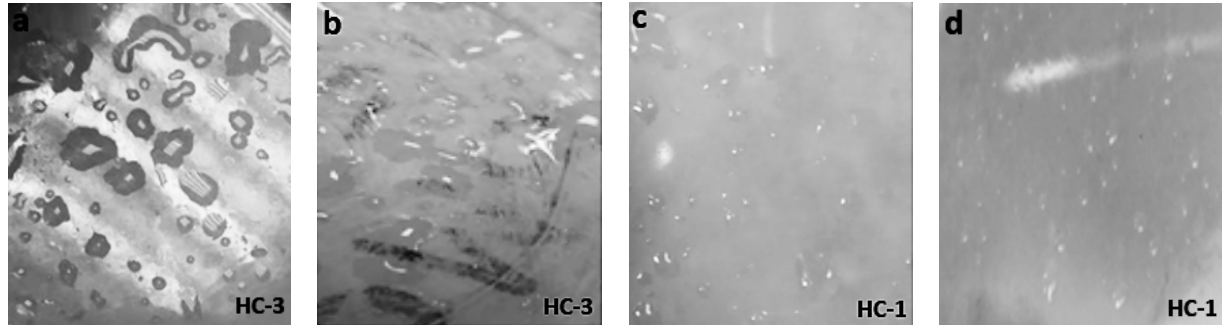
Figure 5. Images of aged (400 h) ( a ) nSiR ( b ) SMC 15 ( c ) SNC 2.5 and ( d ) SNC 5. Figure 5 Images of aged (400 h) ( a ) nSiR ( b ) SMC 15 ( c ) SNC 2.5 and ( d ) SNC 5. Figure 5 Images of aged (400 h) ( a ) nSiR ( b ) SMC 15 ( c ) SNC 2.5 and ( d ) SNC 5. Figure 5 Images of aged (400 h) ( a ) nSiR ( b ) SMC 15 ( c ) SNC 2.5 and ( d ) SNC 5. Figure 5 Images of aged (400 h) ( a ) nSiR ( b ) SMC 15 ( c ) SNC 2.5 and ( d ) SNC 5.